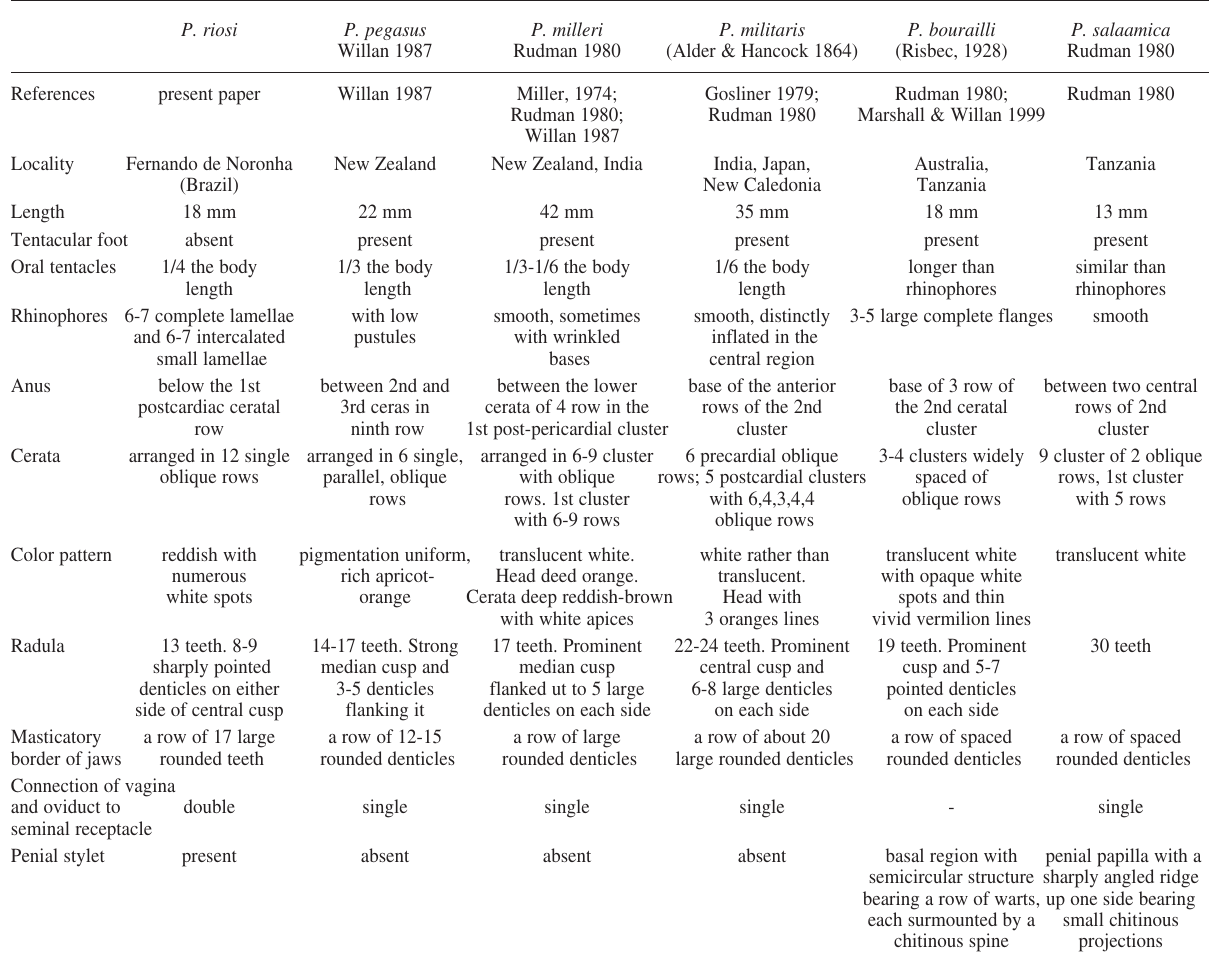
Table 1.- Comparative table of Phidiana